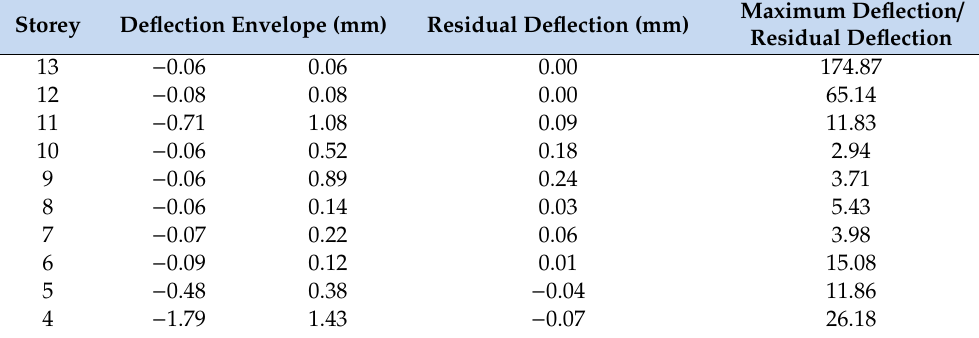
Table 10. THC deformation results for whole building with slab model in ULS case.